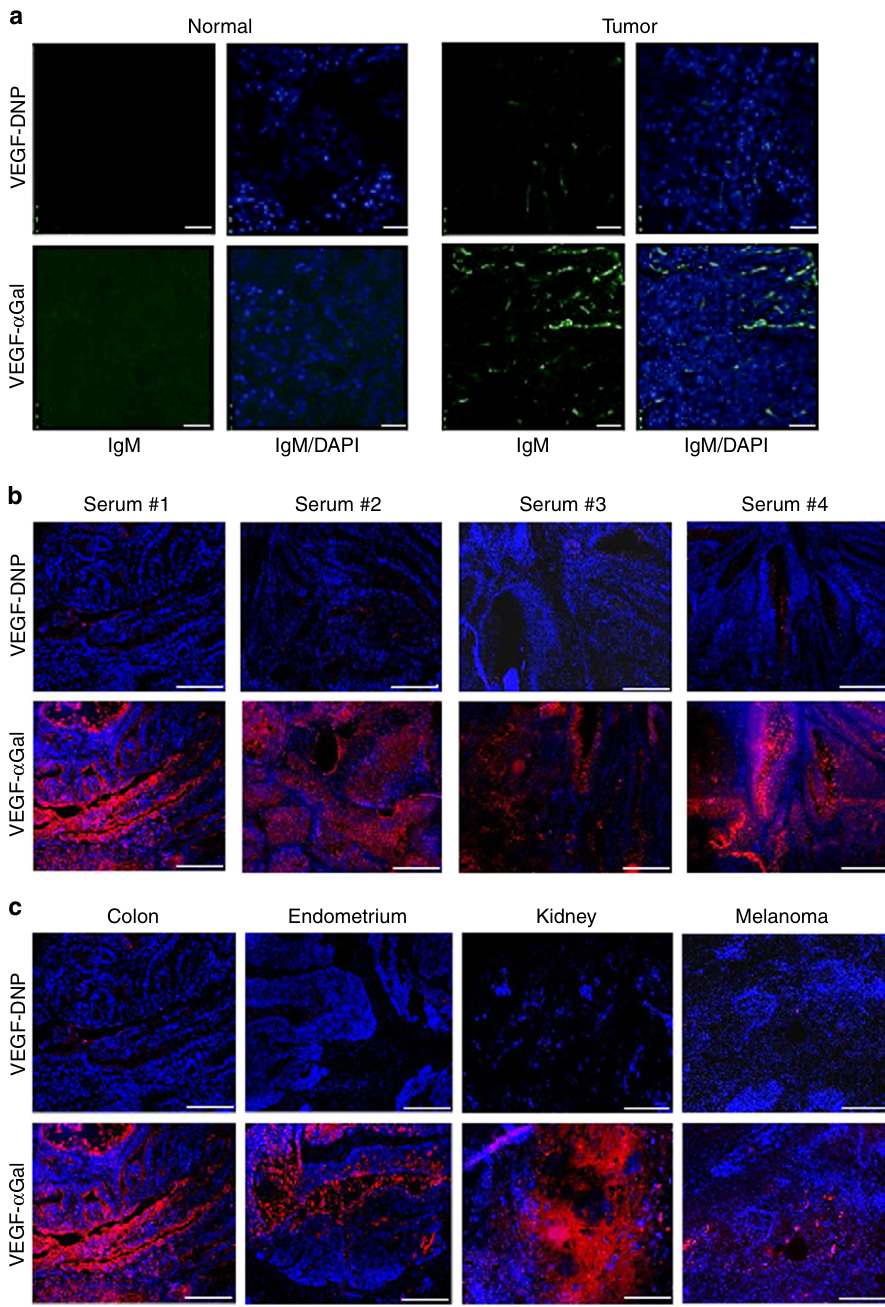
Fig. 7 VEGF- α Gal mediated recruitment of antibodies from human serum to tumor biopsies. Frozen section of normal and tumor biopsies were fi rst incubated with VEGF – DNP or VEGF- α Gal, then with human serum and stained with either DAPI (blue) or with mouse anti-human IgM-Alexa488 A (green) and visualized by confocal microscopy at ×40 magni fi cation. a Renal cell cancer (RCC) and matched normal tissue. b Colon biopsy was incubated with VEGF- α Gal or VEGF – DNP and three additional human sera. c Tumor biopsies from colon (shown in b ), endometrium, kidney (different from a ), and melanoma were incubated with VEGF – α Gal or VEGF – DNP conjugate and the human serum used in a . Scale bar = 25 μ m. ( n =